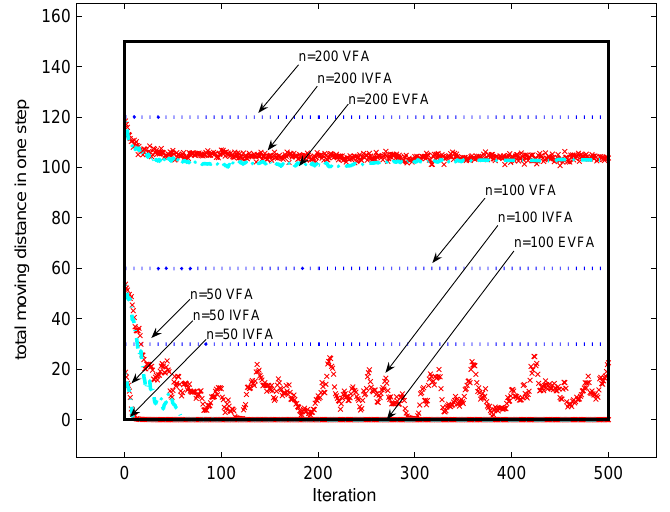
Figure 4 . E under VFA, IVFA, EVFA with different n d